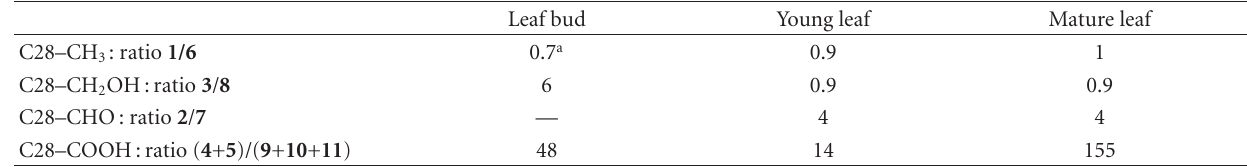
Table 3: Ratio of oleanane- to ursane-type triterpenoids following oxidation steps of the C-28 CH 3 throughout olive tree leaf development. Leaf